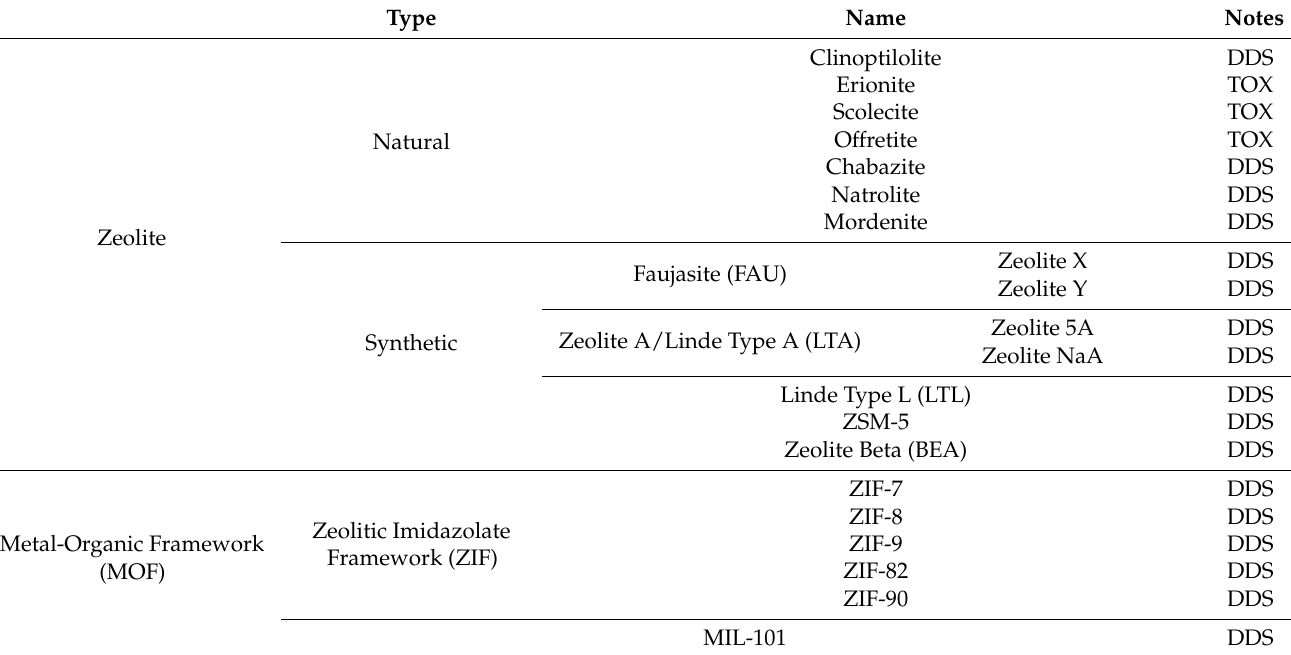
Table 1. Types of Zeolites and Zeolite-like Compounds Mentioned in This Systematic Review.